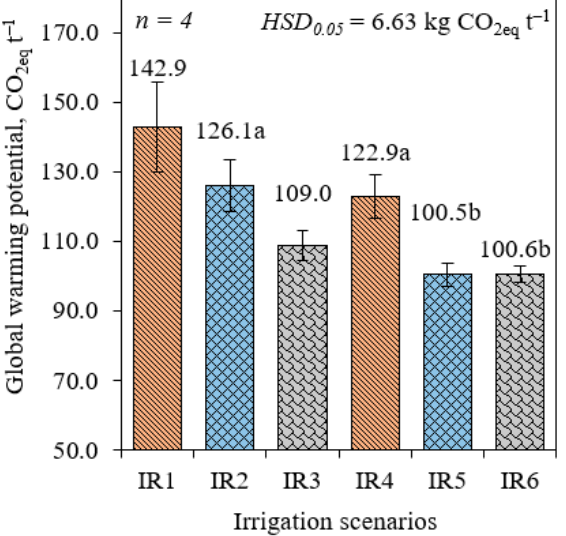
Figure 9. The impact of different irrigation scenarios on the environment when growing wheat fodder hydroponically using a 7-day growth cycle. Four repetitions n were performed in each scenario. Any two samples with a common letter are not significantly different ( p > 0.05), as assessed using honestly significant difference.